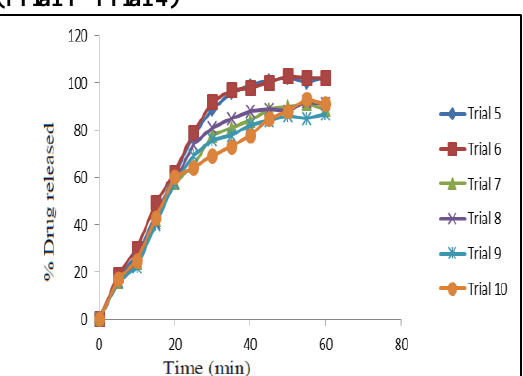
Figure 10. In-vitro drug dissolution profiles (Trial 1- Trial 4)